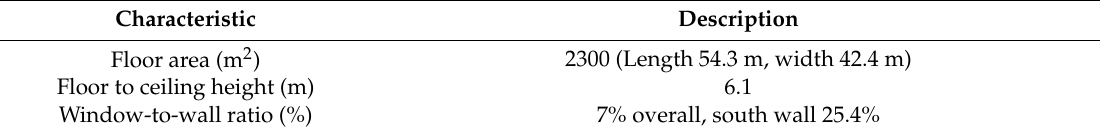
Table 1. Modeling Specifications of Standalone Retail Building Prototype